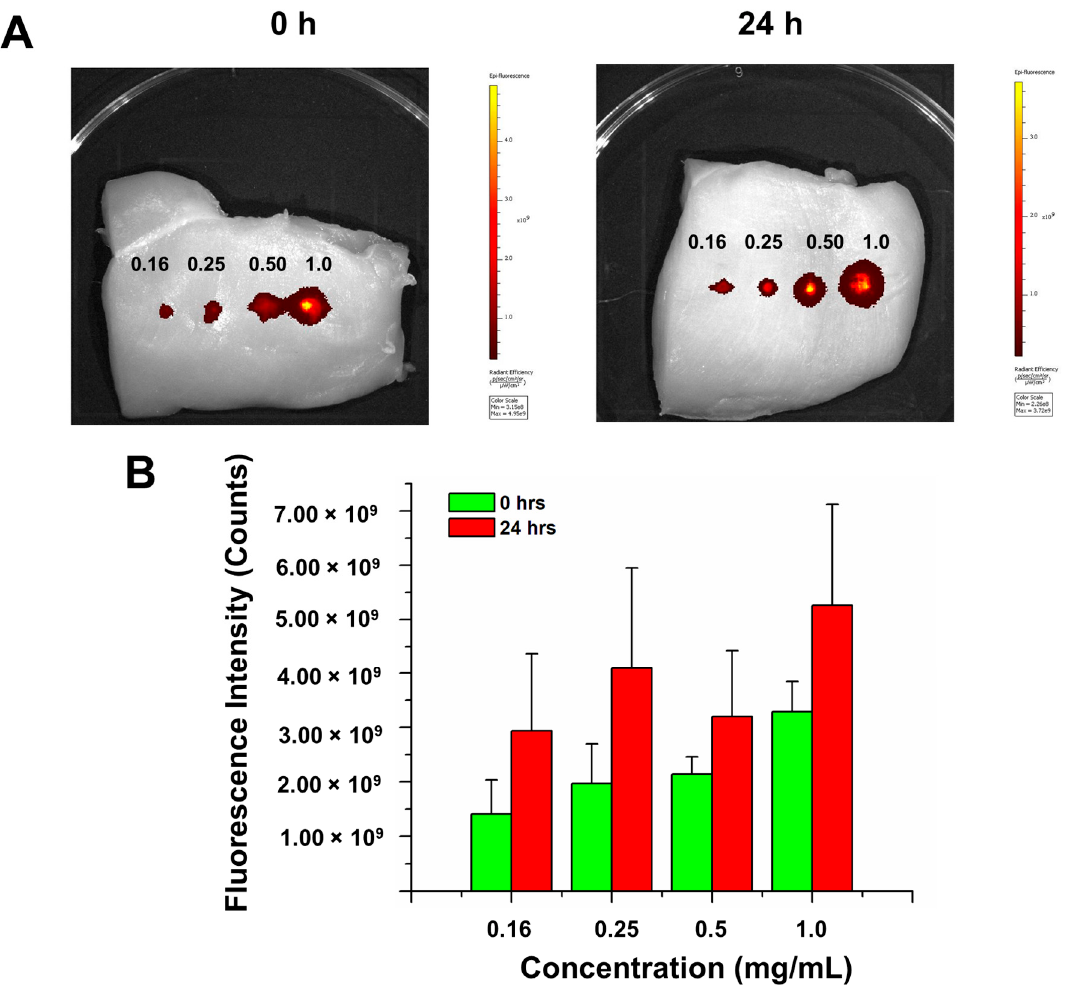
Figure 5. Ex Vivo tissue imaging capability of bay leaf extracts. ( A ) Physical evidence of NIR fluorescence of bay leaf extracts on chicken breast tissue at 0 time and after 24 h, and ( B ) fluorescence quantification of bay leaf extracts. Data represent the average of three different experiments.